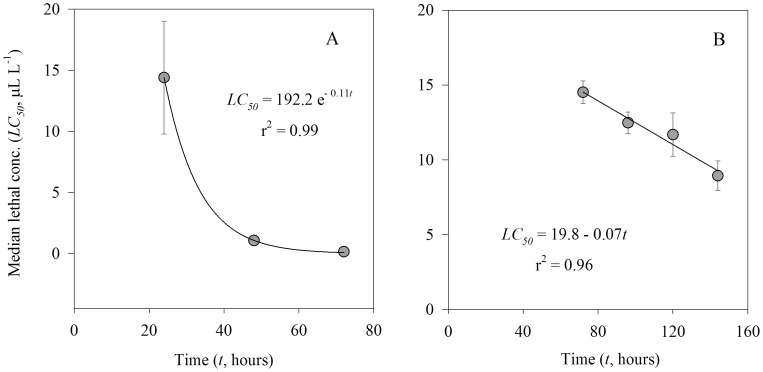
Relationships between median lethal concentration (LC50, µL L−1) and incubation time (t, hours) of ephyra larvae of the scyphozoan Aurelia aurita (A) and cydippid larvae of the ctenophore Mnemiopsis leidyi (B) exposed to crude oil.